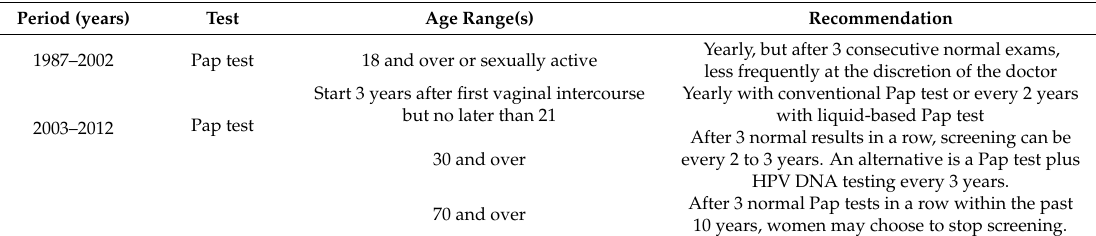
Table 1. Recommendations of the American Cancer Society (ACS) for Pap tests during